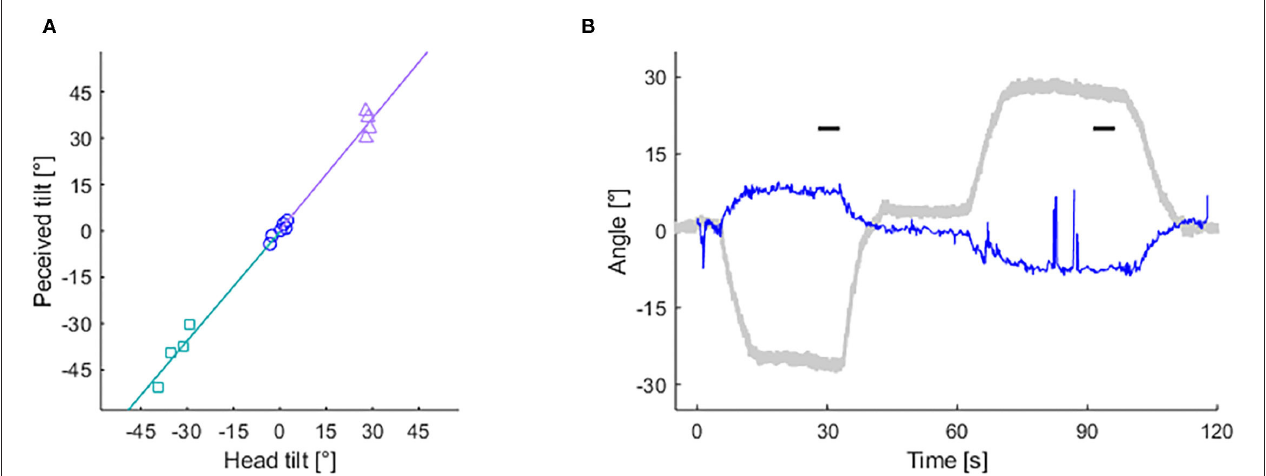
FIGURE 3 | Records of subjective visual vertical (SVV) and ocular counter-rolling (OCR) tests from a MS susceptible individual. (A) Slope of lines depict left (based on rectangle-dots) and right (based on triangle-dots) head-tilt subjective visual vertical (HT-SVV) gain ( S l and S r , respectively). Circle dots are used to calculate head-upright SVV. (B) Eye torsion (blue thin line) and head tilt (gray bold line) angle during the OCR test. Short horizontal bars depict 5s time periods used for calculating OCR gains.